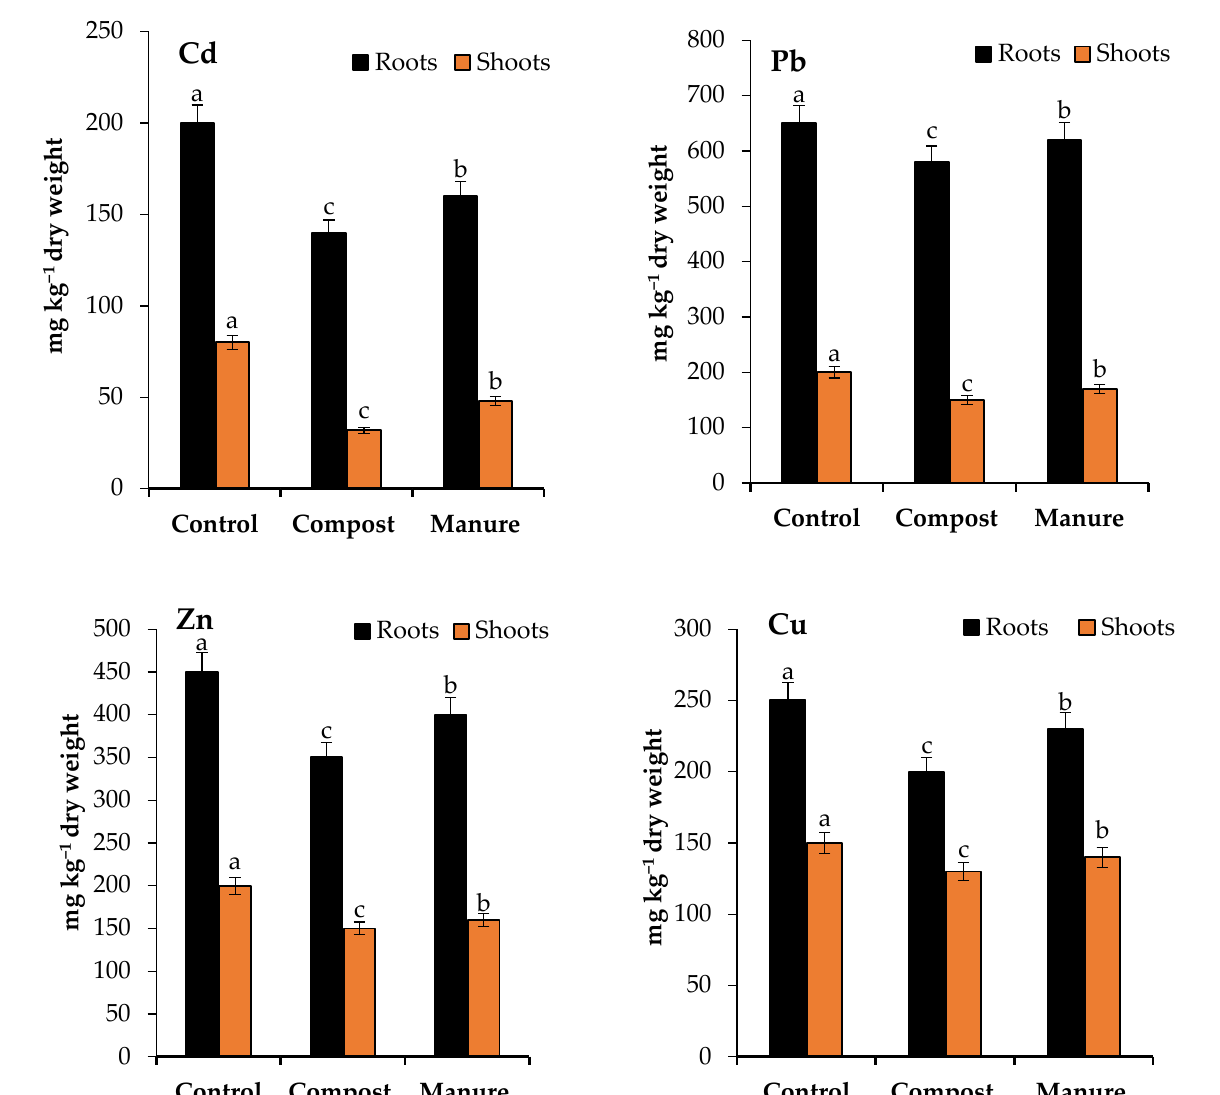
Figure 2. Effect of compost and manure on heavy metals content in the roots and shoots. Means ( ± standard deviation, n = 4) denoted by different letters are significantly different at p < 0.05.